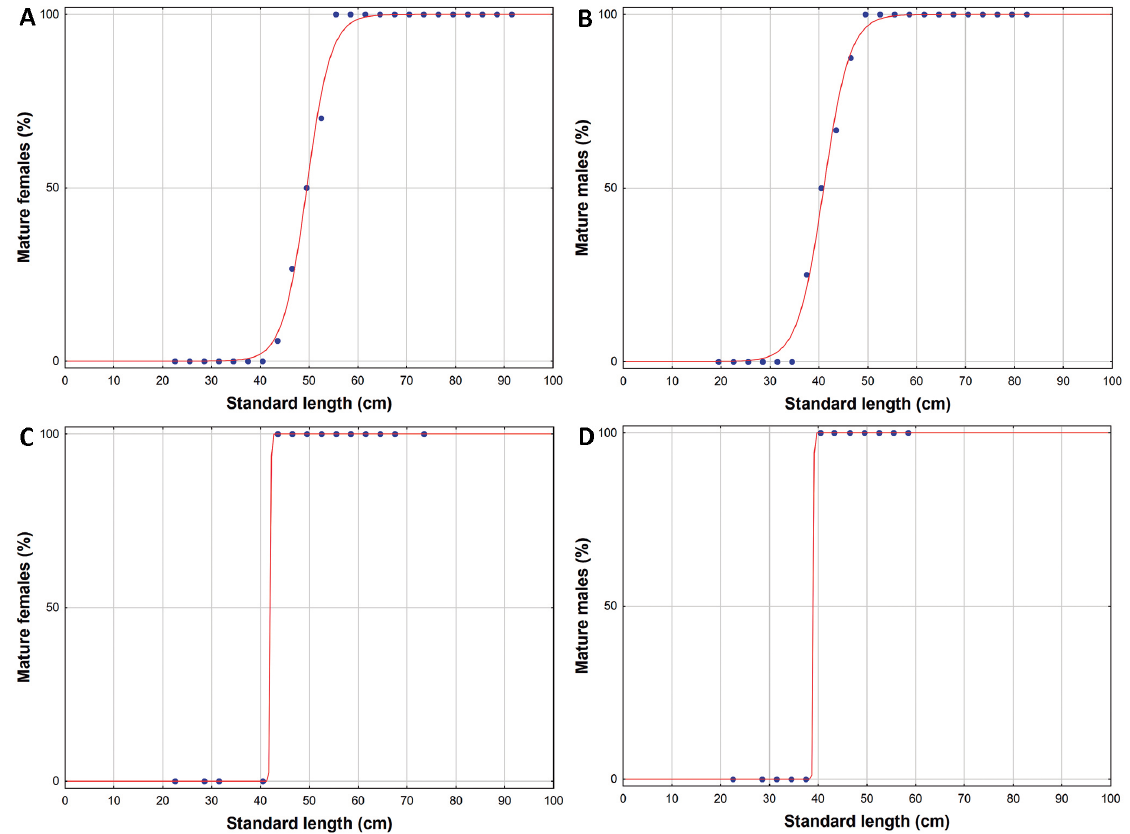
FIGURE 7 | Standard length at first sexual maturity ( L